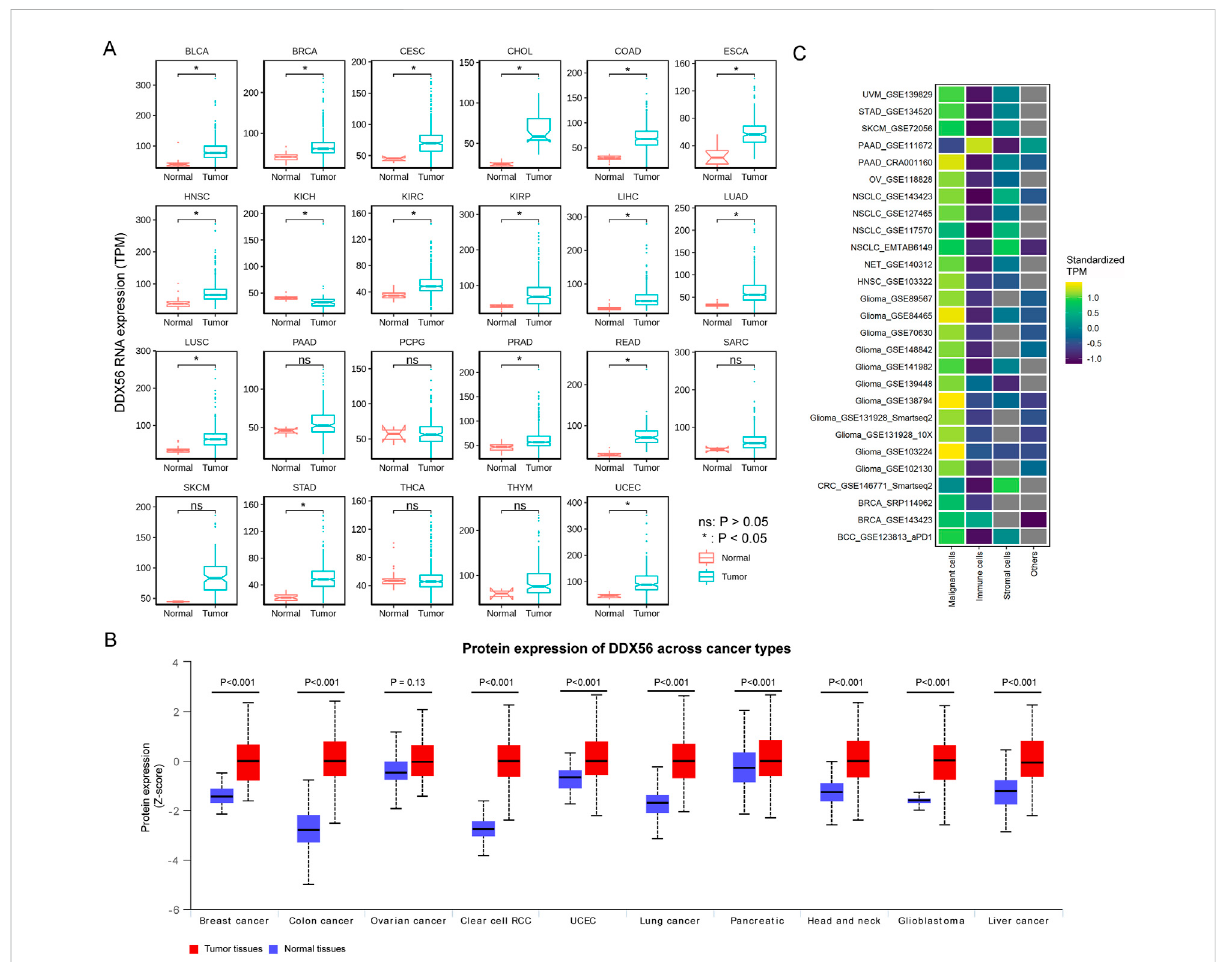
RNAandproteinexpression ofDDX56 invarioustumors. (A) Boxplots showingRNAexpression of DDX56 indifferenttissues (Wilcoxon test). P - values are marked. (B) Box plots showing protein expression levels of DDX56 in different tissues (T test). P -values are marked. (C) Heat map showing RNA expression in different cell types of various tumors. TPM values were standardized for each tumor. The colors indicate the TPM value after standardization. The X-axis indicates single-cell RNA-seq datasets. The Y-axis indicates the cell type. Abbreviations: BLCA, bladder urothelial carcinoma; BRCA, breast invasive carcinoma; CESC, cervical squamous cell carcinoma and endocervical adenocarcinoma; CHOL, cholangiocarcinoma; COAD, colon adenocarcinoma; ESCA, esophageal carcinoma; GBM, glioblastoma multiforme; HNSC, head and neck squamous cell carcinoma; KICH, kidney chromophobe; KIRC, kidney renal clear cell carcinoma; KIRP, kidney renal papillary cell carcinoma; LIHC, liver hepatocellular carcinoma; LUAD, lung adenocarcinoma; LUSC, lung squamous cell carcinoma; PAAD, pancreatic adenocarcinoma; PCPG, pheochromocytoma and paraganglioma; PRAD, prostate adenocarcinoma; READ, rectum adenocarcinoma; SARC, sarcoma; SKCM, skin cutaneous melanoma; STAD, stomach adenocarcinoma; THCA, thyroid carcinoma; THYM, thymoma; UCEC, uterine corpus endometrial carcinoma; BCC, basal cell carcinoma; NET, Neuroendocrine tumor; CRC, colorectal cancer; RCC, renal cell